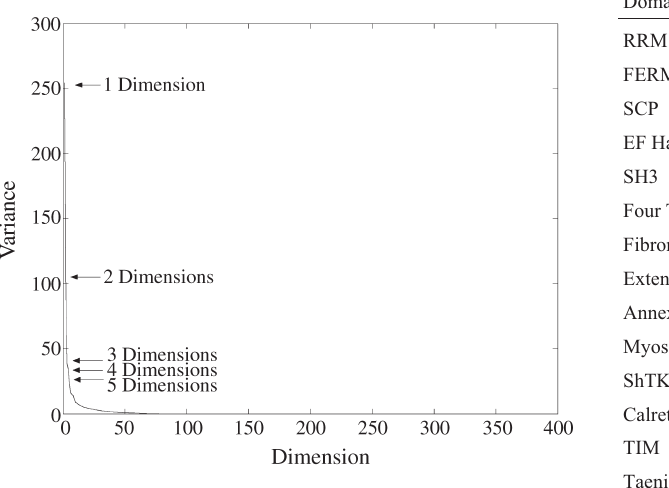
Figure 5 - Singular values (variances) of the decomposed cross- correlation matrix.